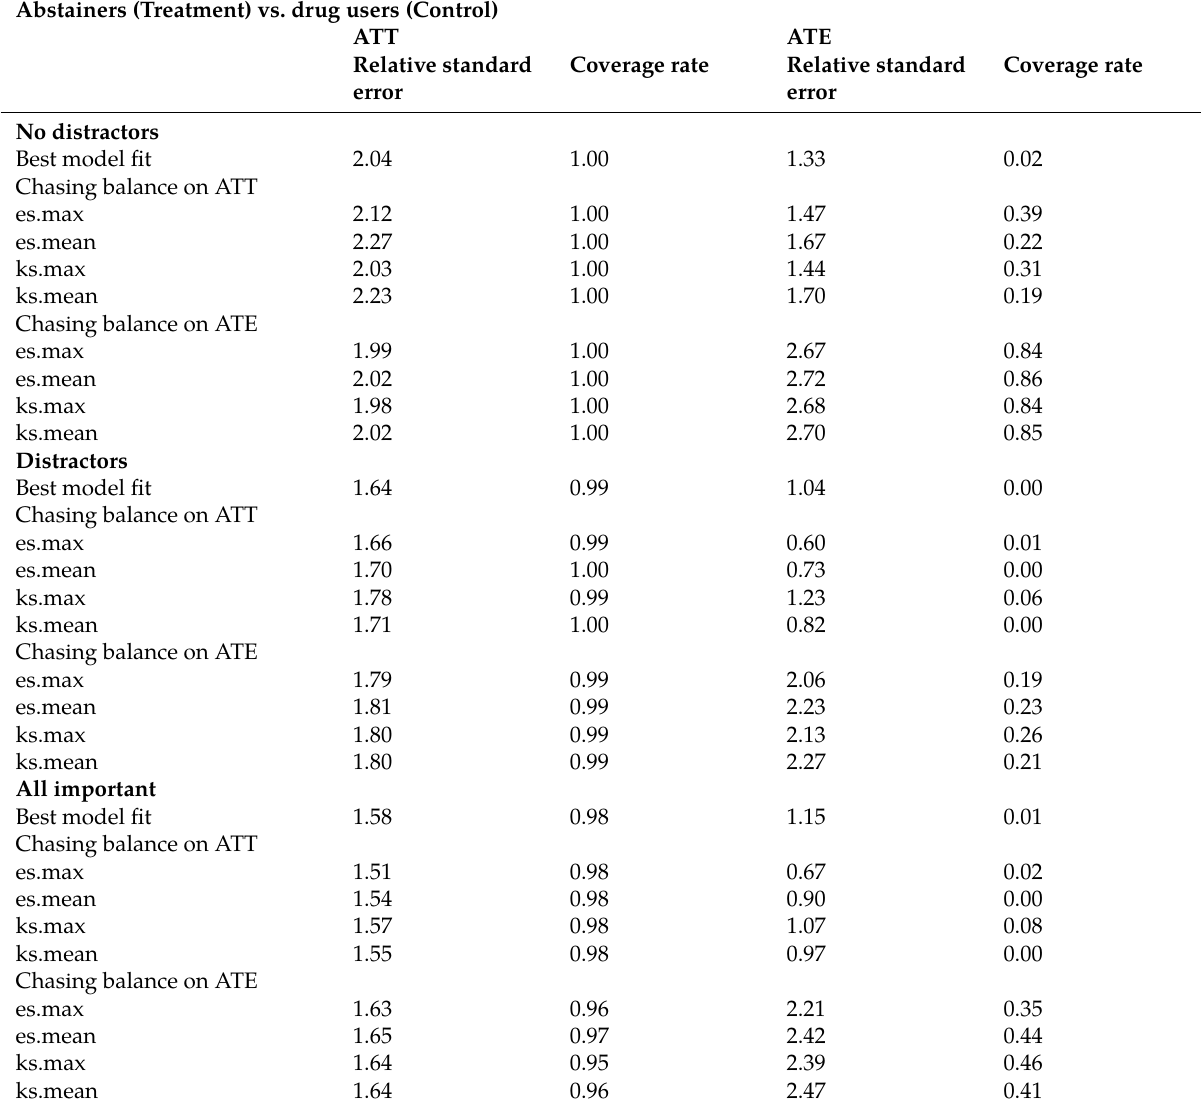
Table 8: Relative standard errors and coverage rates for all stopping rules and methods considered for the abstainers example.